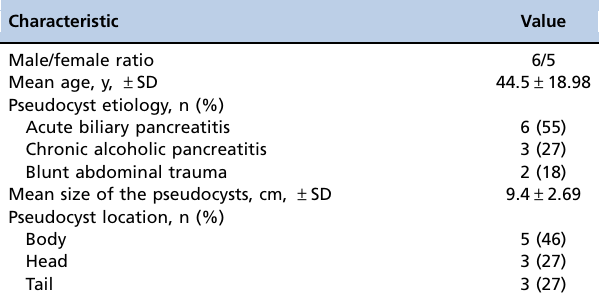
Table 1 - Demographic characteristics of the patients and details of the pseudocysts (N=11).